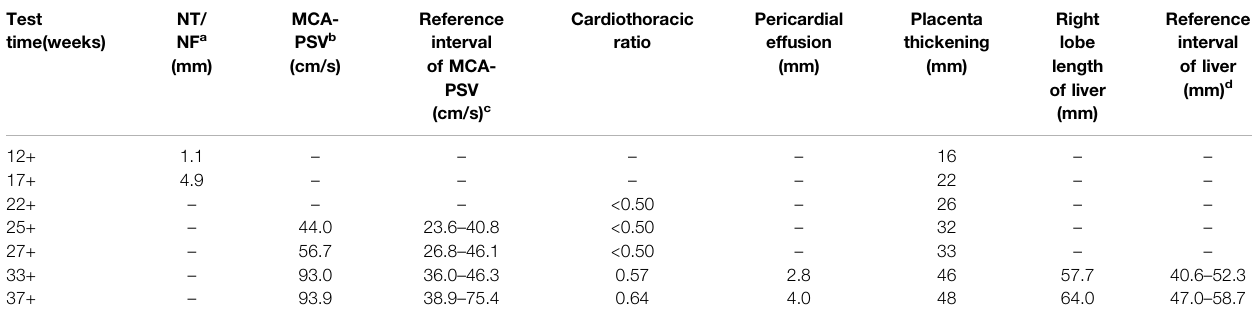
TABLE 1 | Ultrasound fi ndings of II:2 at different gestational weeks.